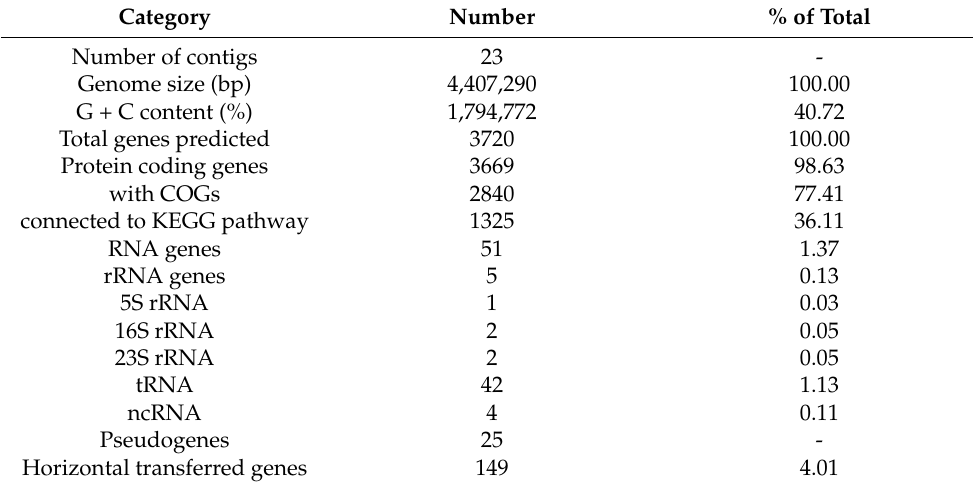
Table 1. General genome features of Robertkochia solimangrovi